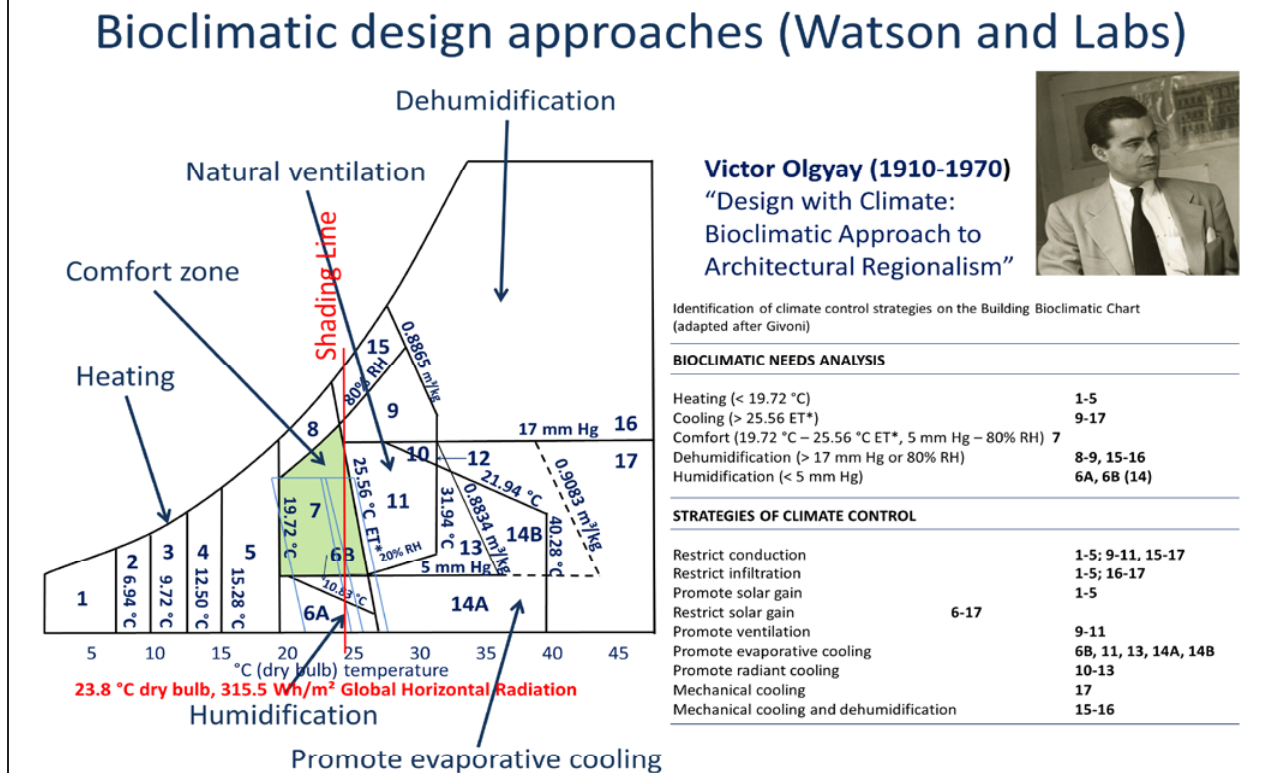
Figure 14: Climate control strategies as an overlay on a simplified psychrometric chart